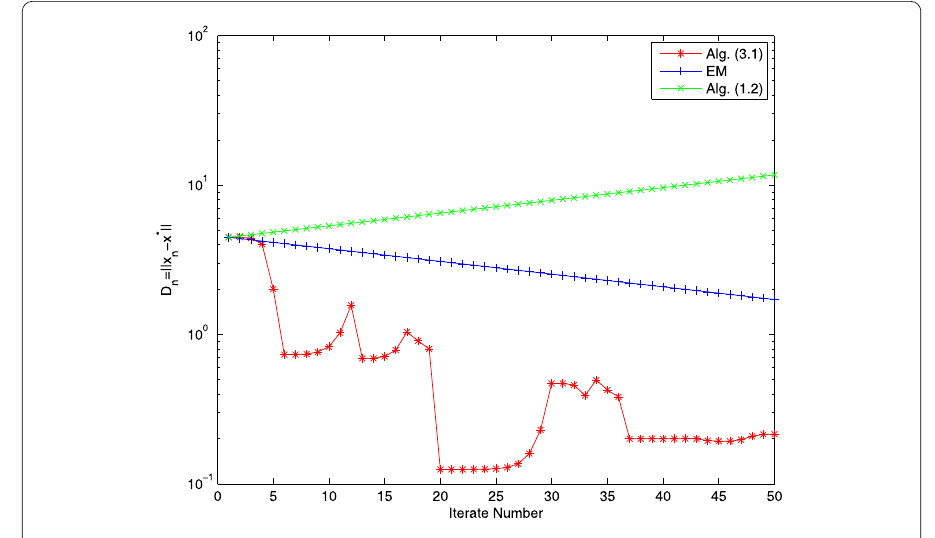
Figure 2 Numerical results as regards Example 2